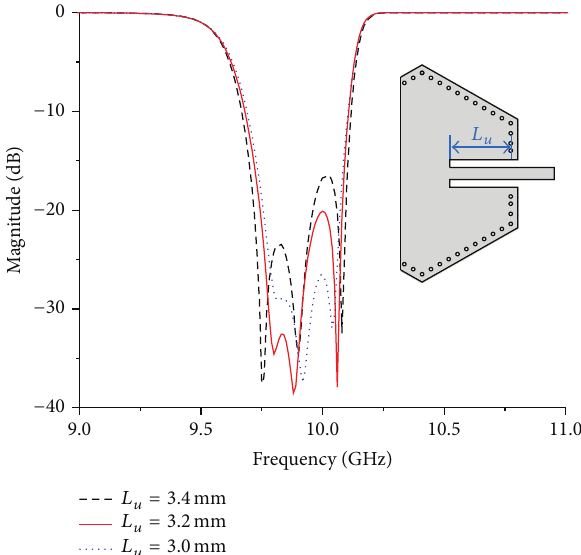
Figure 3: Effect of GCPW’s length on return loss in Filter A.